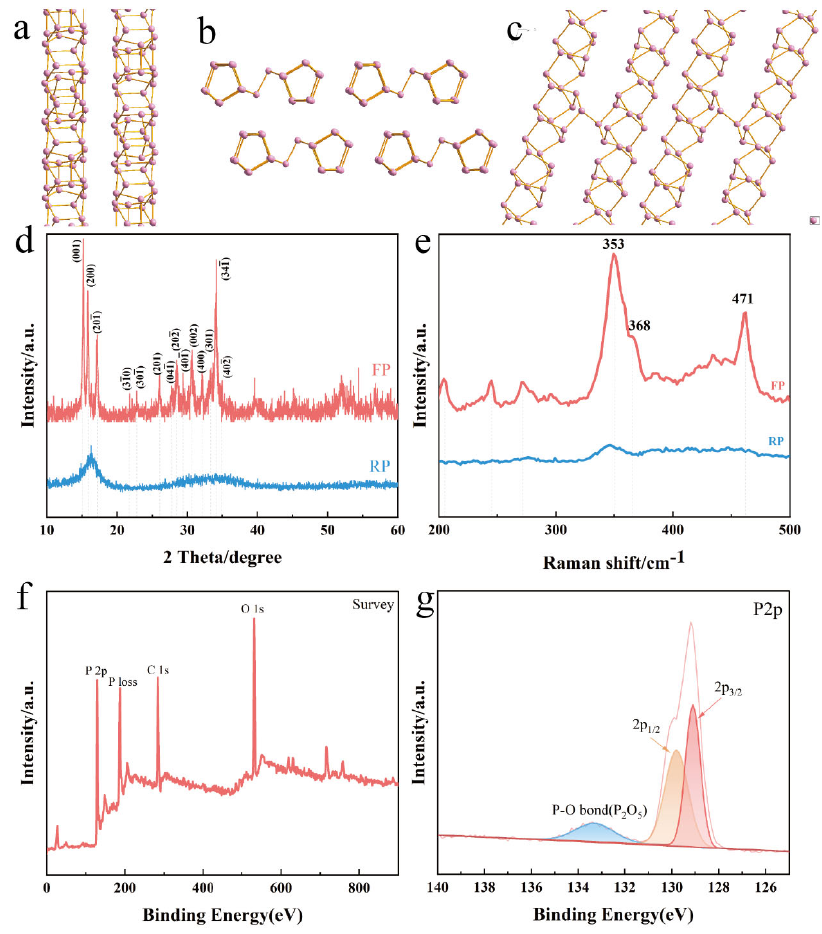
Figure 2. Schematic structural view of FP along the a ( a ), b ( b ) and c ( c ); ( d ) XRD curves and ( e ) Raman spectra of RP and FP; ( f ) XPS survey spectrum of FP; ( g ) P2p spectrum of FP.